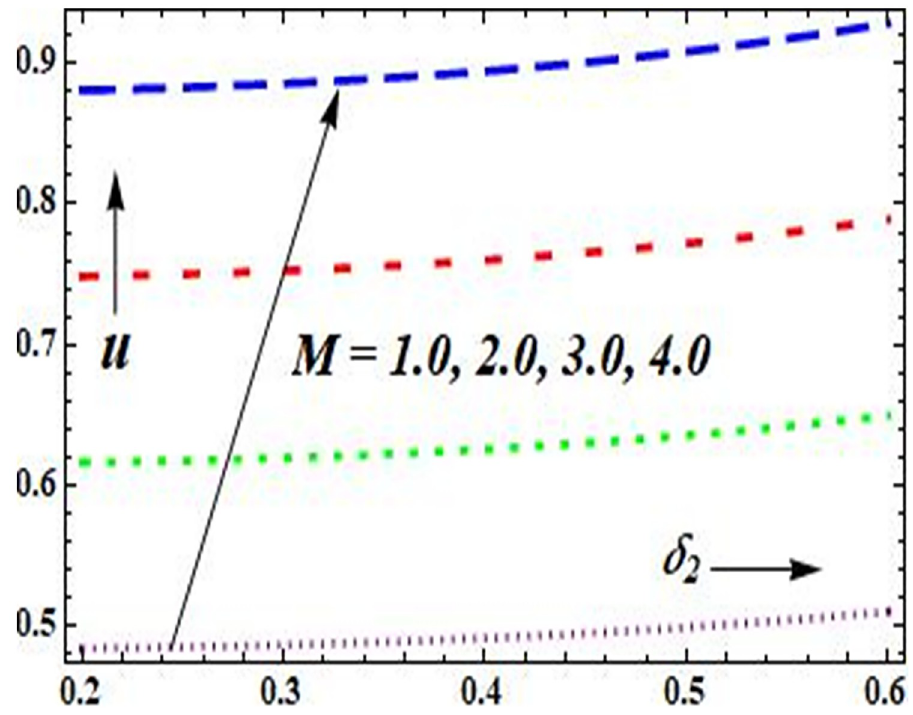
Fig 21. Plot of u on M & δ 2 with ϕ ¼ π